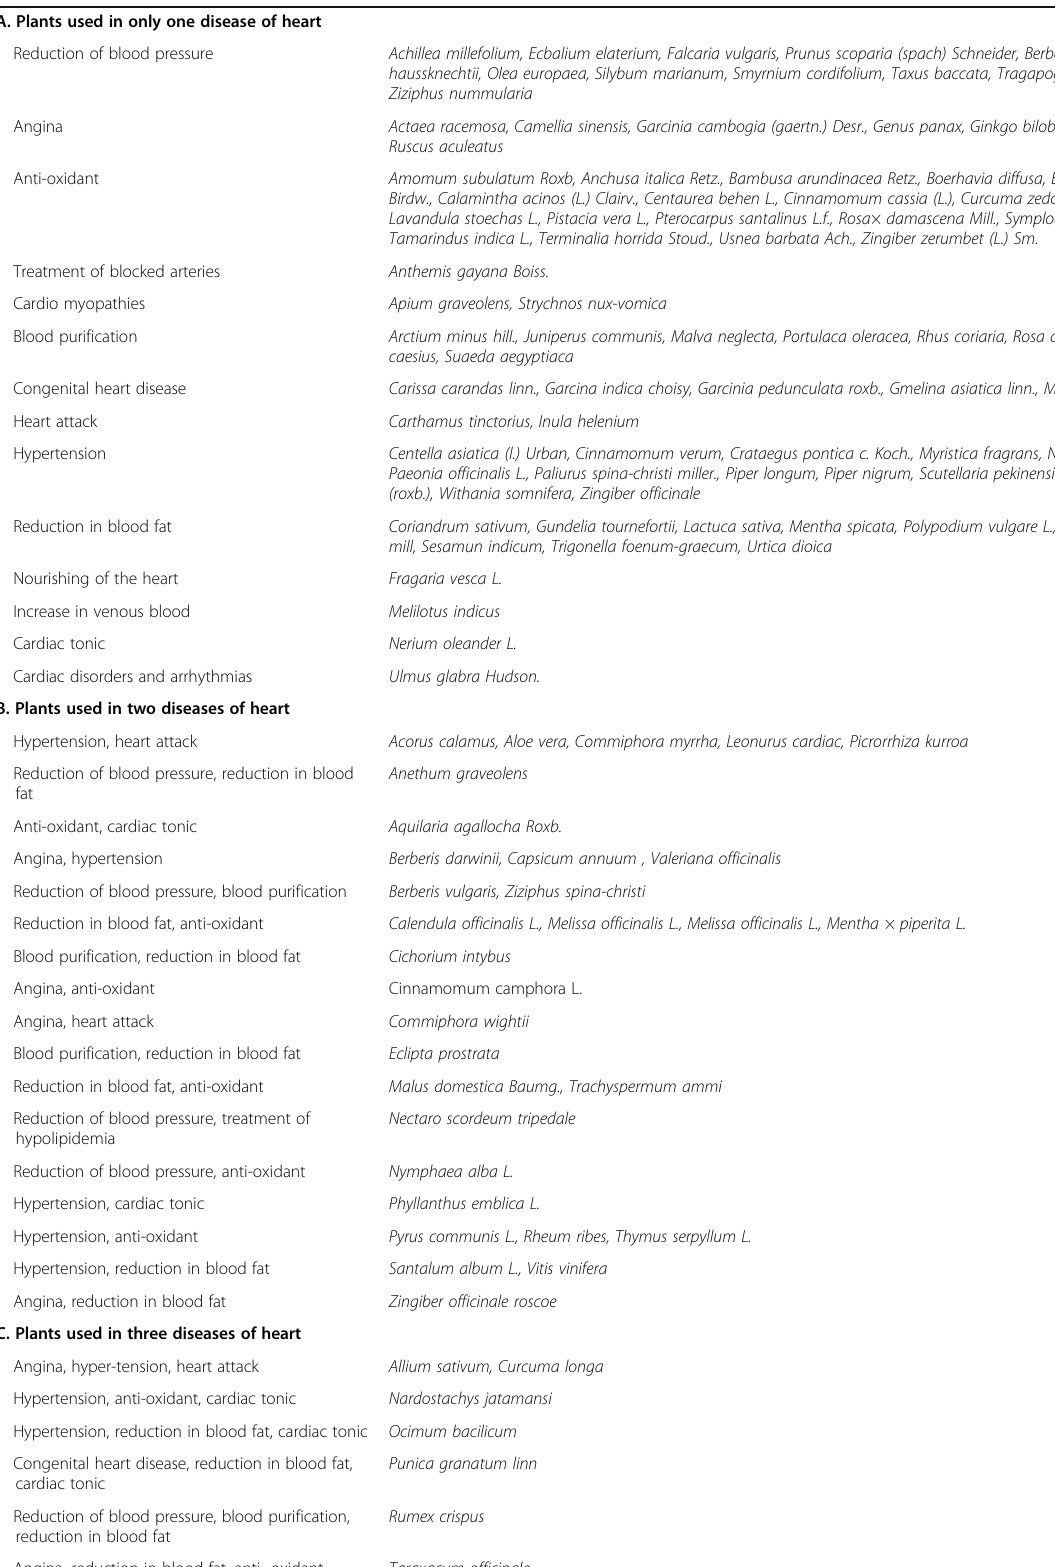
Table 2: Heart disease and the Plant Uses (A-C) A. Plants used in only one disease of